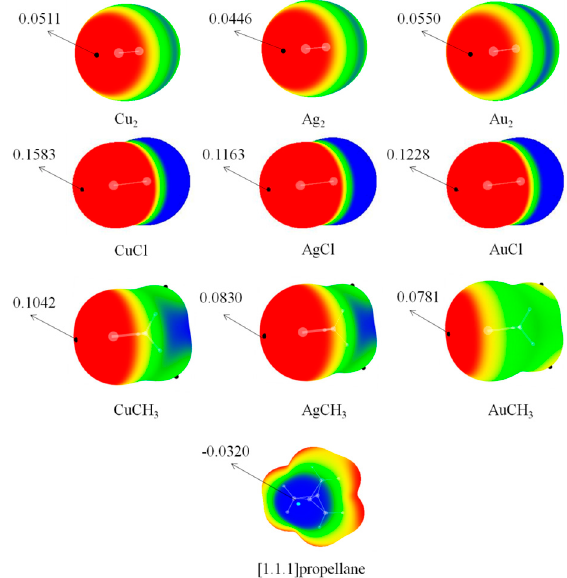
Figure 2. Molecular electrostatic potential (MEP) maps on the 0.001 electrons bohr − 3 isosurface of the monomers studied. Color ranges, in au, are: Red, > 0.02; yellow, 0.02–0; green, 0– − 0.02; blue, < − 0.02.